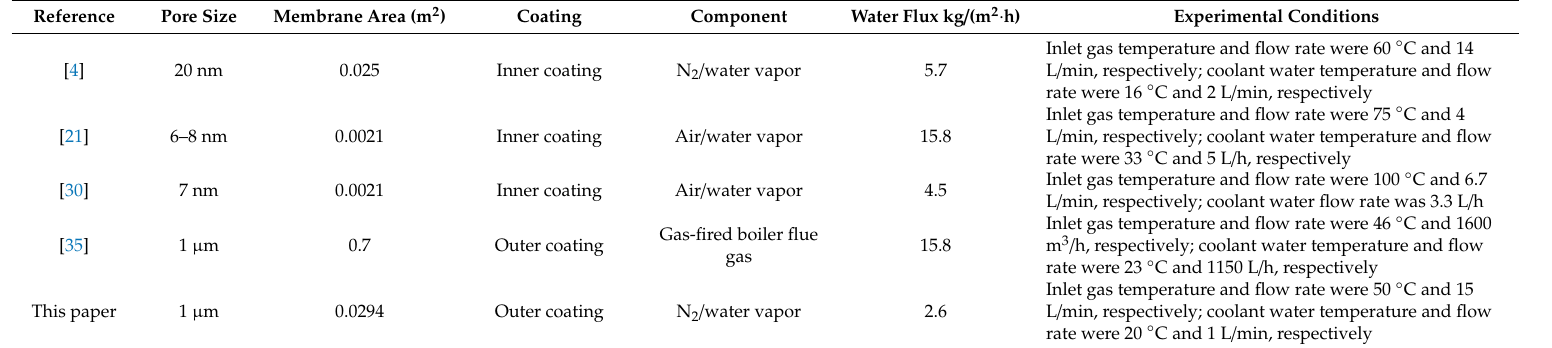
Table 3. Di ff erent research results under di ff erent experimental conditions.